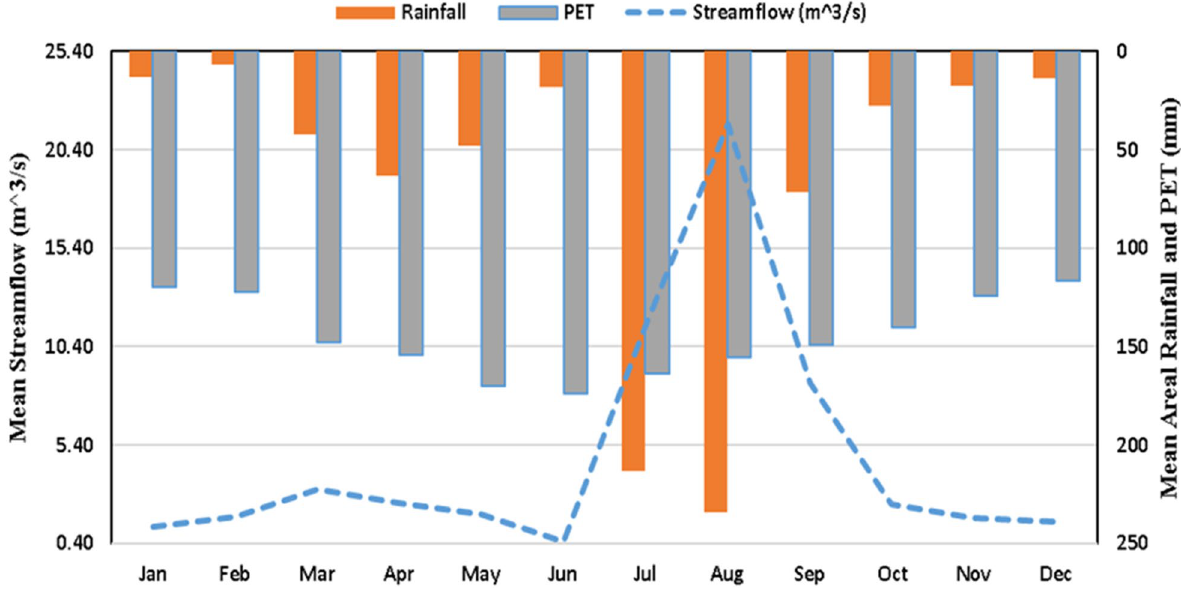
Fig. 2 Mean monthly streamflow (m. 3 /s), areal rainfall, and PET